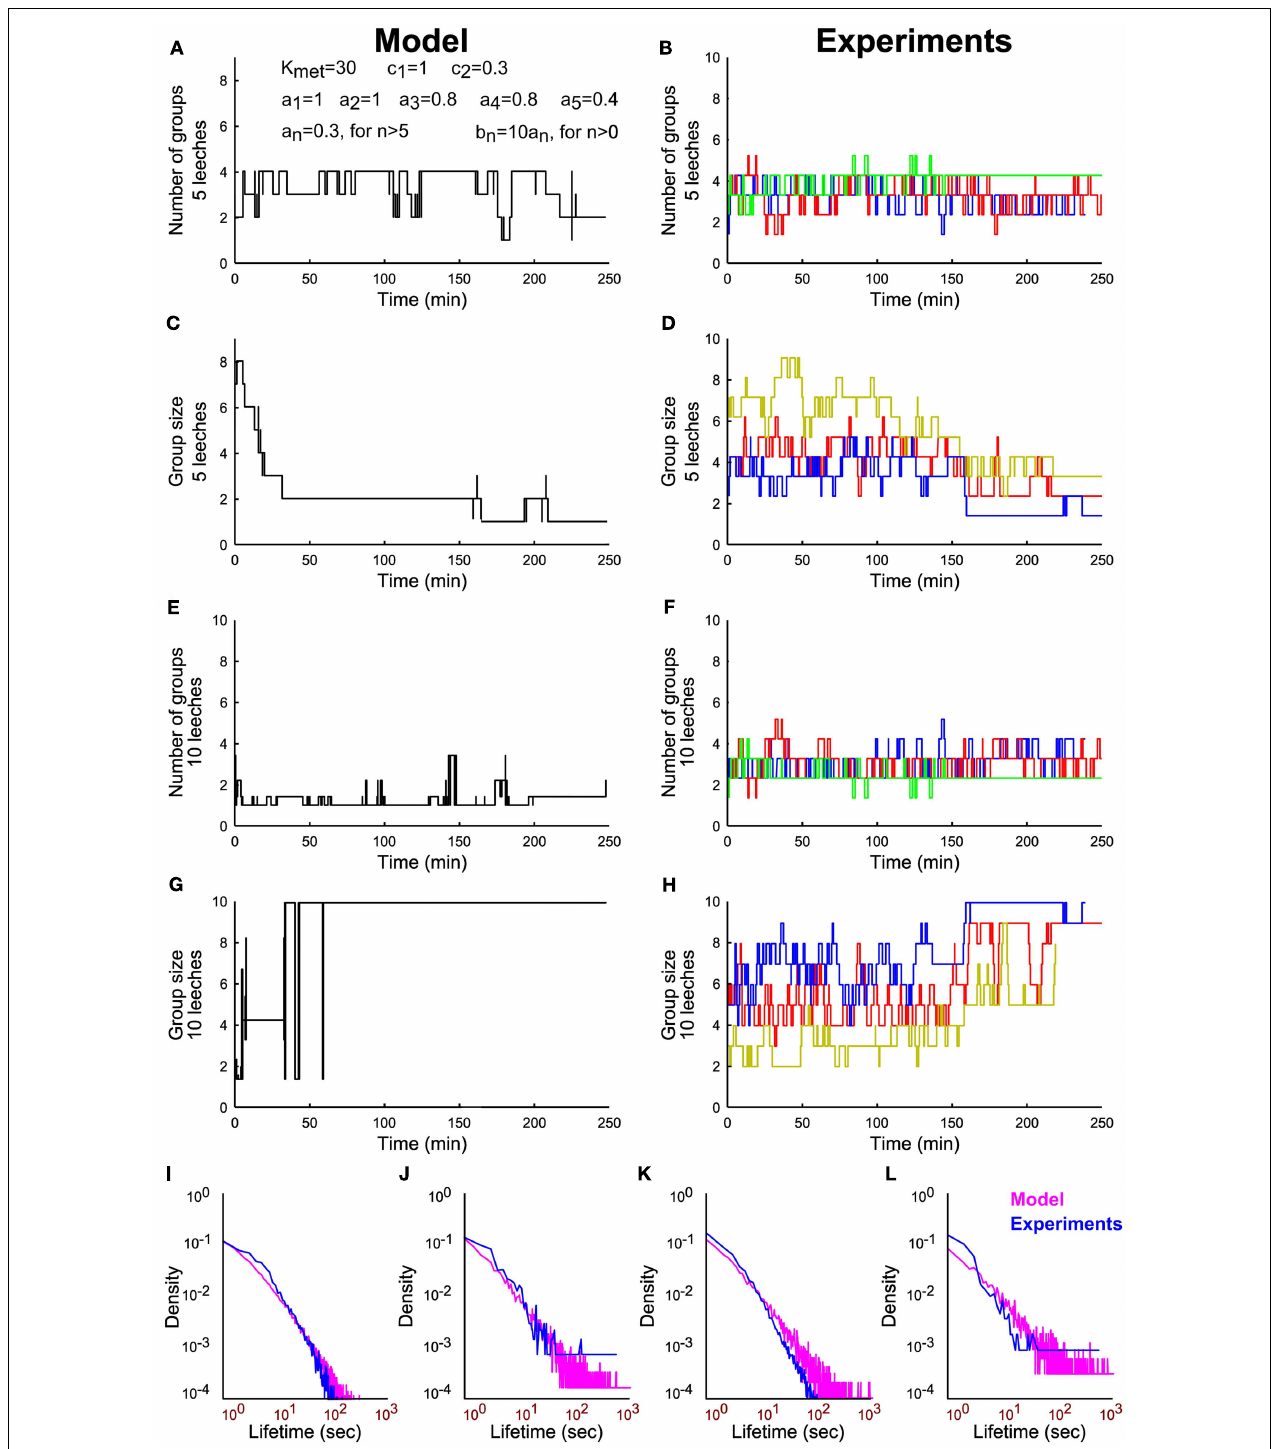
FIGURE 9 | Modeling group formation in leeches and comparison with experimental data. (A) Time evolution of number of groups from a simulation of Eqs 3–5 with five leeches and using the parameters K met = 30; c 1 = 1; c 2 = 0.3; a 1 = 1, a 2 = 1, a 3 = 0.8, a 4 = 0.8, a 5 = 0.4, and all other a n = 0.3, b n = 10* a n . (B) Time evolution of number of groups in three different experiments with five leeches. (C) Time evolution of the average group size